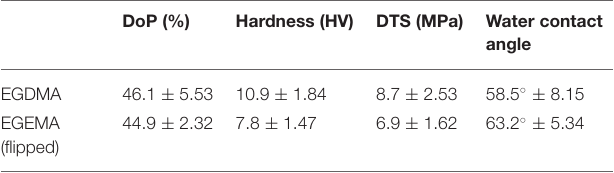
Table based on data presented in reference (28, 30,